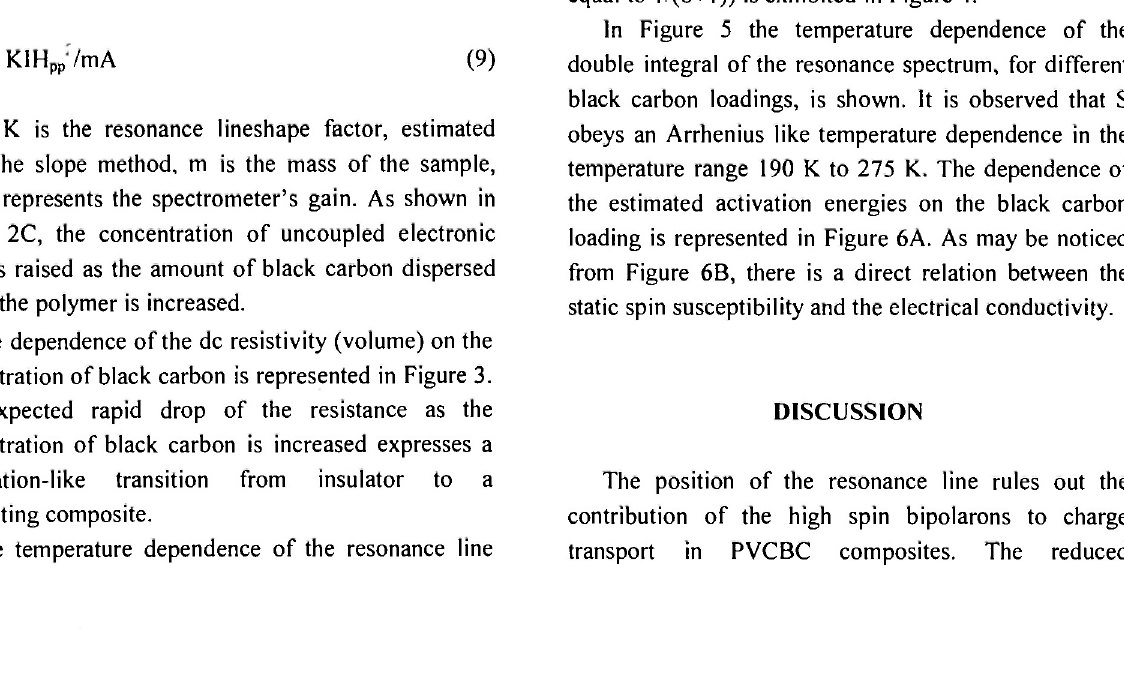
Fig. 2: A. The dependence of the resonance line intensity on the black carbon loading in PVCBC composites. PVC.